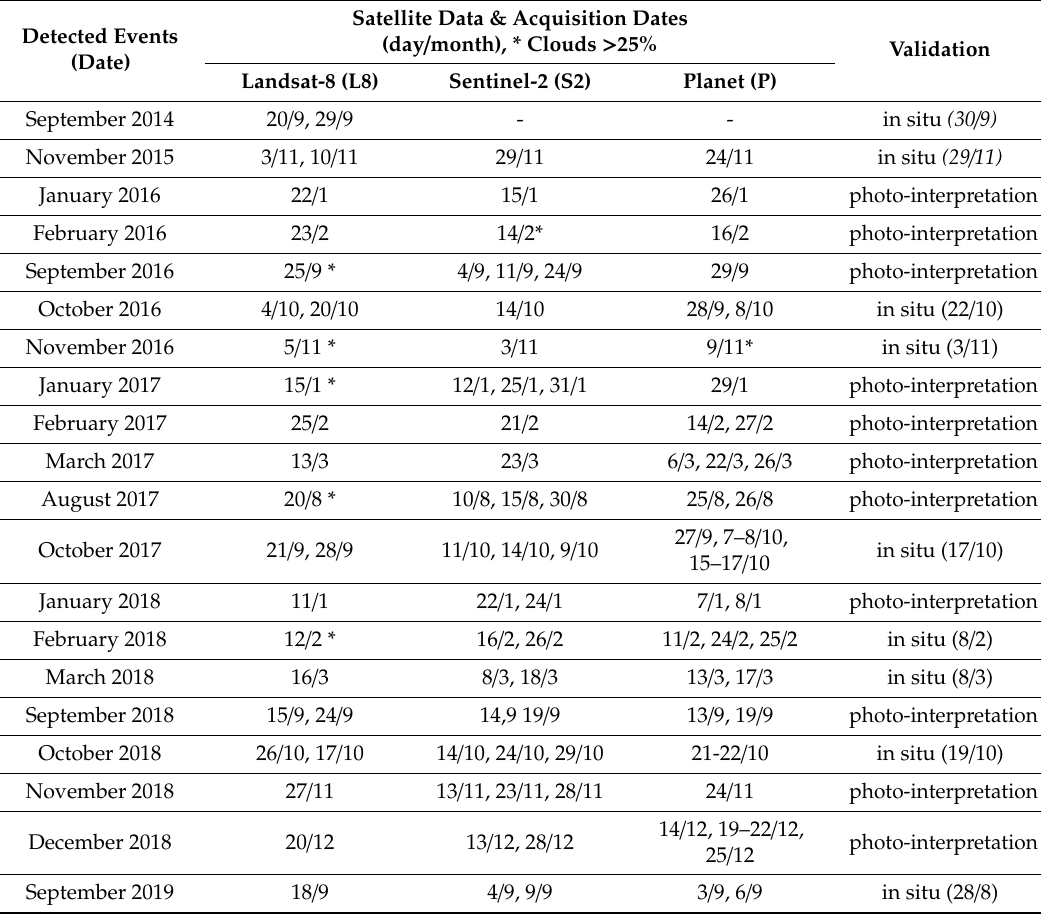
Table 1. The detected 20 plastic debris events for the years 2014 to 2019 based on satellite and in situ